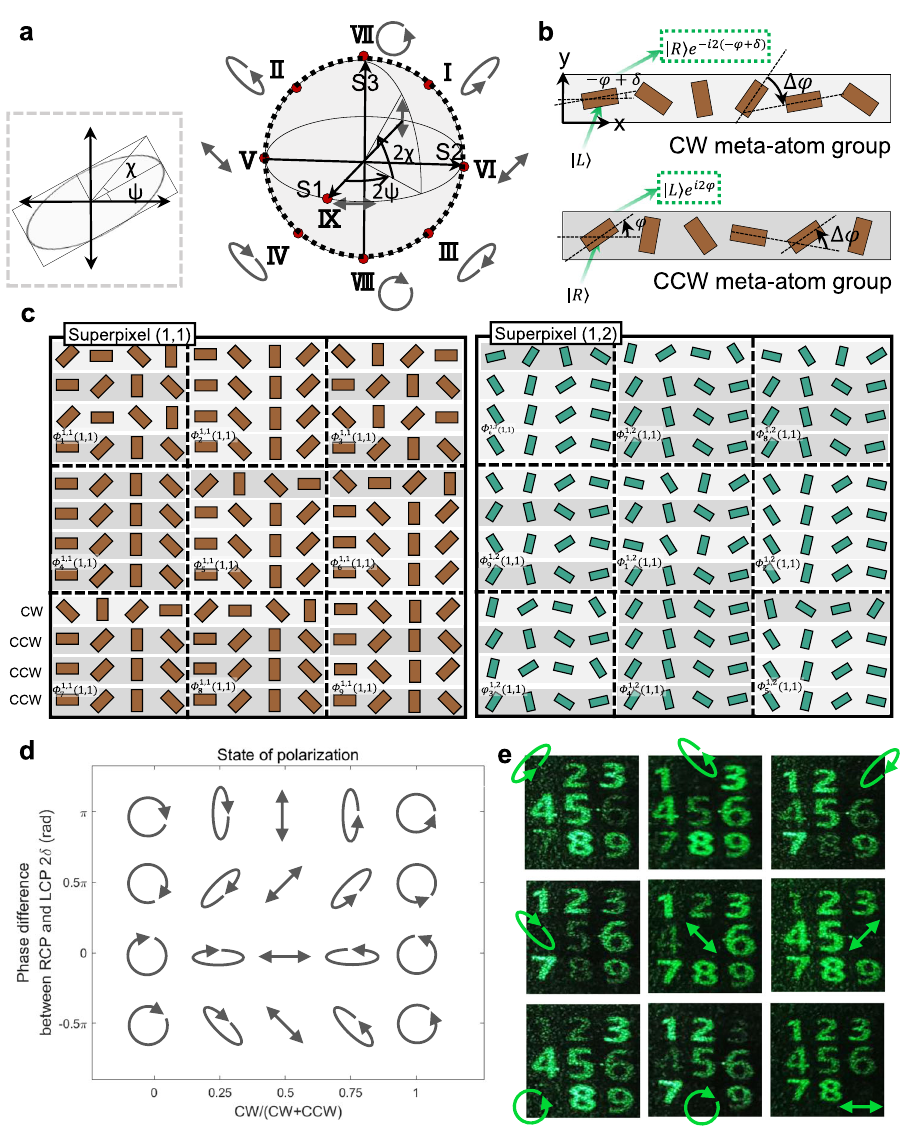
Fig. 3 Design method of vectorial hologram using PB phase-based pixelated metasurfaces. a Polarization ellipse and Poincare sphere representing polarization states with different azimuth ψ and ellipticity χ angles. Polarization states I to IX are experimentally demonstrated. b Two types of meta-atom groups to generate outgoing RCP and LCP with arbitrary phase. c Schematic of the metasurfaces that are composed of two different sized meta-atoms exhibiting color prints and pixelated for vectorial holographic devices. The initial phase difference between two different sized meta-atoms is compensated and the subpixels at each superpixel are randomly ordered to remove the unwanted grating effect. d Realization of the arbitrary polarization states by changing the relative phase and amplitude between RCP and LCP. On the Poincaré sphere, the longitudinal and latitudinal variation is modulated by arbitrary phase and amplitude of two circular polarizations. e Experimental demonstration of the hologram images carrying nine different polarization states. Each holographic image is blocked by the corresponding combination of wave retarder and atoms whose angle increment satis fi es 4 φ > 0 (Fig. 3b — CCW amplitude of the RCP and LCP in transmitted wave is achieved by 4 φ modulating the number of CW and CCW groups. We design a group), the phase-gradient 2 along the x axis is obtained at the P superpixel to produce multiple polarization states in single outgoing LCP, where P denotes the pixel pitch. As a result, device as shown in Fig. 3c. Each superpixel consists of nine according to the generalized Snell ’ s law, the outgoing LCP is types of subpixel, generating nine polarization states. In other ¼ arcsin ð 2 4 φ Þ , where k denotes the free de fl ected to the angle θ d 0 k 0 P words, multiple polarization states can be realized at space wavenumber 49 . Likewise, the same amount of phase- corresponding subpixels with different combination of phase gradient and de fl ection angle at the outgoing RCP is achieved by and amplitude difference between CPs (Fig. 3d). The number the meta-atom groups satisfying 4 φ < 0 (Fig. 3b — clockwise of meta-atoms that make up the CW and CCW groups are (CW) group). On the premise that both RCP and LCP are determined considering the de fl ection ef fi ciency (Supplemen- de fl ected to same angle by modulating relative angle increment tary Note 5 and Supplementary Fig. 5). Moreover, a twin- 4 φ , the phase of the outgoing RCP and LCP is modulated by the image is inherently generated from metasurfaces composed of absolute angle of the meta-atom: φ and (cid:3) φ þ δ as shown in these two phase-gradient groups (CW and CCW) illuminated Fig. 3b that result in 2 δ difference between CPs. Then, the